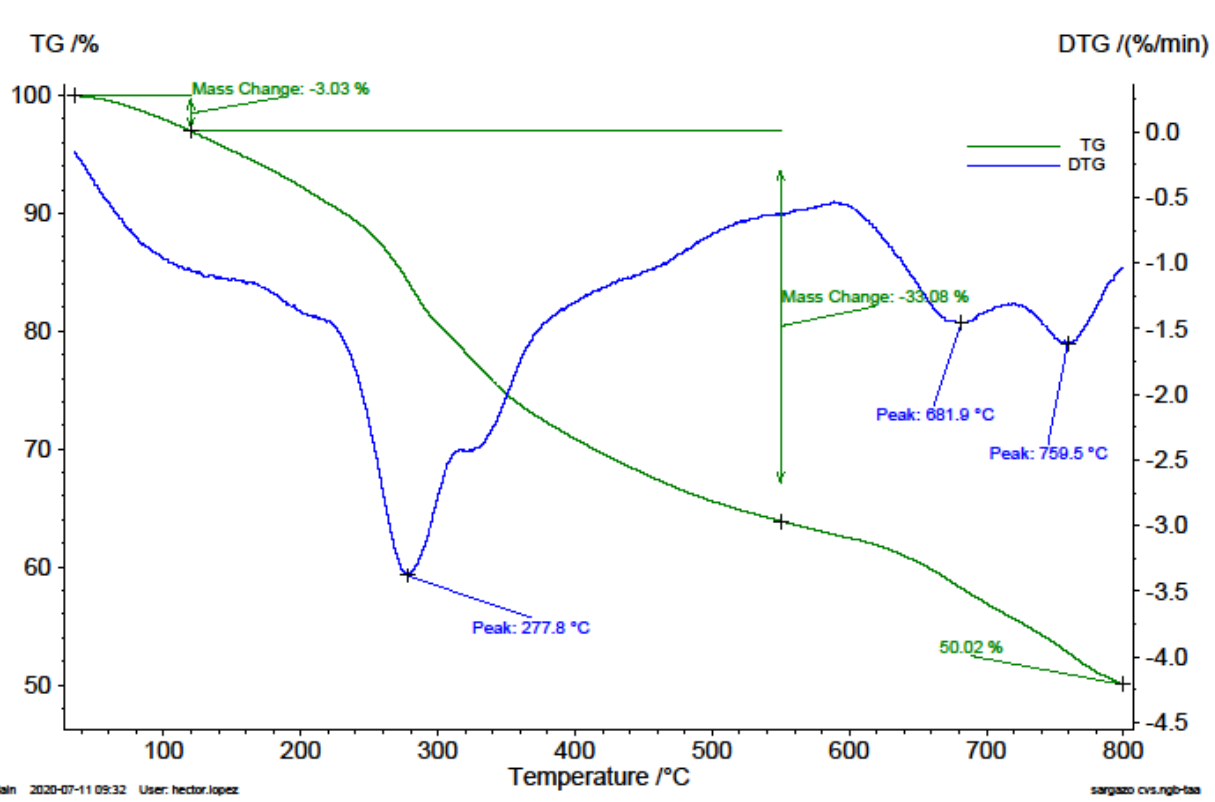
Figure 3. TG an DTG thermograms of Mexican Caribbean macroalgae consortium sample (A3).